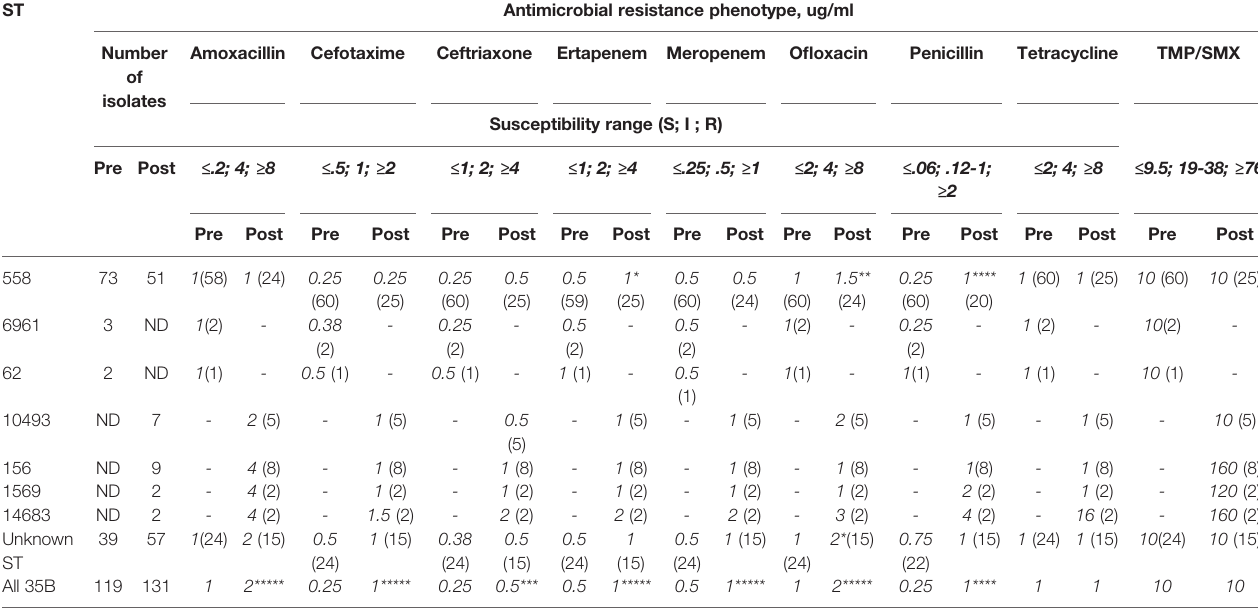
TABLE 2 | MIC50 changes between pre-2015 and post-2015 in each sequence type. ST Antimicrobial resistance phenotype,